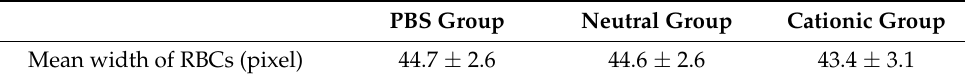
Figure 5. In vivo cationic liposomes – blood interaction. Microscopic images of blood smears from mice treated with ( A ) PBS, ( B ) neutral, and ( C ) cationic liposomes. Images obtained at a 40× magnification. Black and red identify schistocytes and hemolysis, respectively. Table 2. Effect of the repeated administration of PBS, neutral, and cationic liposomes on the mean width of red blood cells (RBCs).